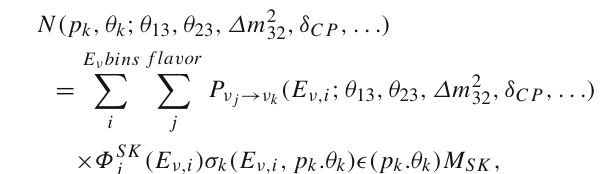
events for neutrinos and 6.28 events for anti-neutrinos in the case of normal mass hierarchy. In addition, a new event sam- ple using electron neutrino events with one decay electron is added in neutrino beam mode. The single electron-ring selec- tion predominantly consists of electron neutrino CC interac- tions. One decay electron could come from a π → μ → e pion decay where the pion Cherenkov ring is invisible due to low pion momentum. So, electron neutrino events with one decayelectronarepredominantlyelectronneutrinoCCsingle π production events. This sample is called e-like+1 π + .